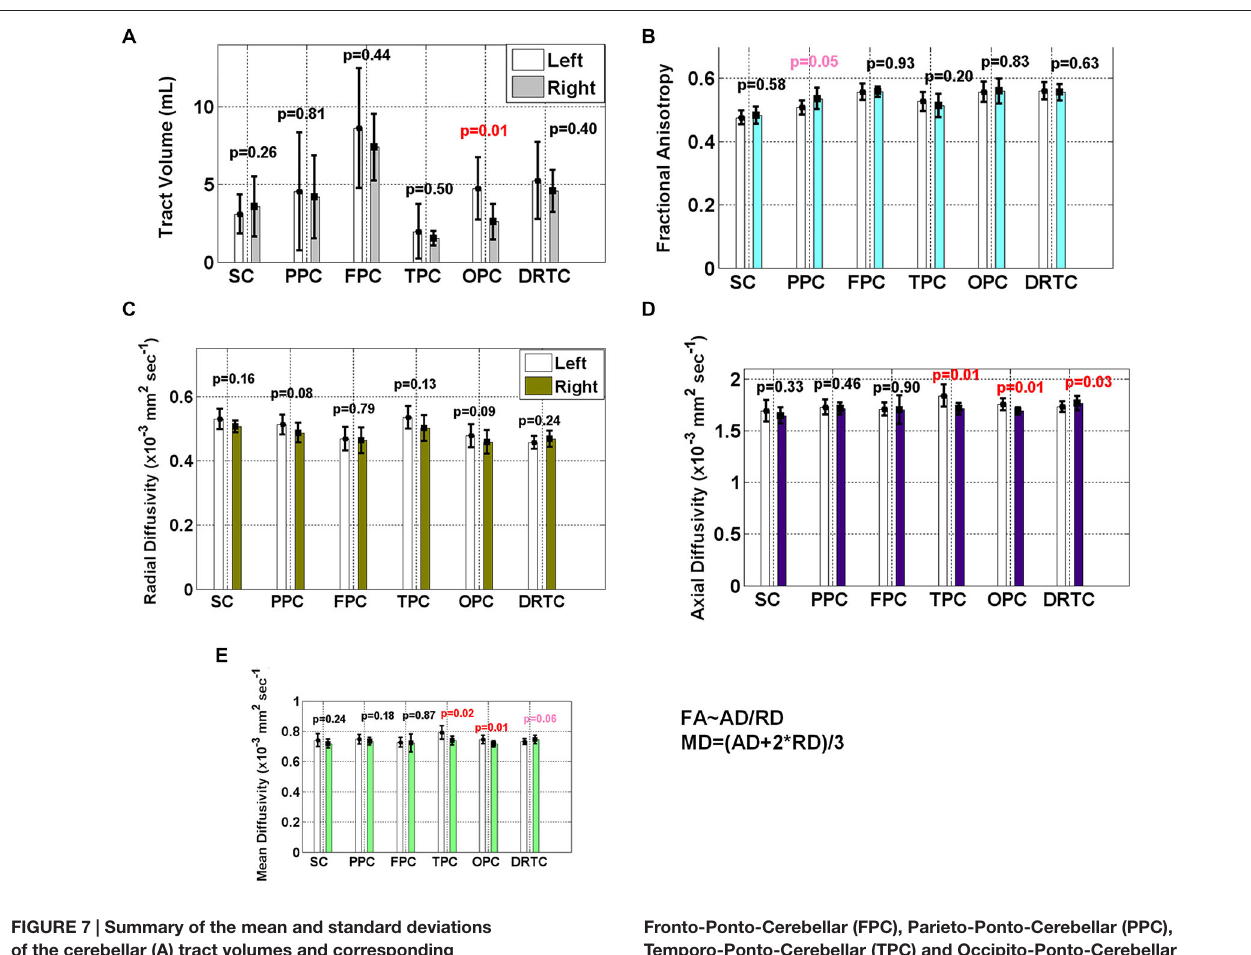
FIGURE 7 | Summary of the mean and standard deviations of the cerebellar (A) tract volumes and corresponding (B) fractional anisotropy (FA), (C) radial diffusivity (RD), (D) axial diffusivity (AD) and (E) mean diffusivity (values of the bilateral SC, Dentate-Rubro-Thalamo-Cortical (DRTC),